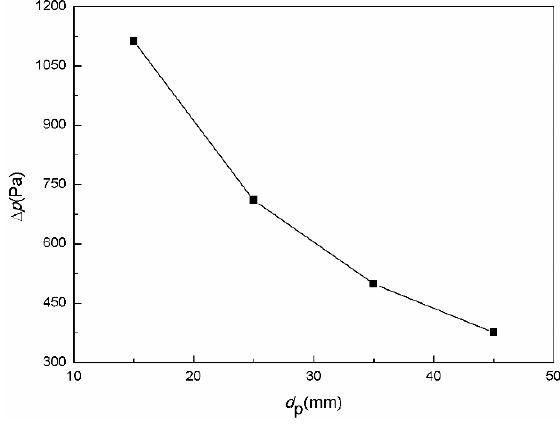
Figure 17. Influence of the sinter particle diameter on pressure drop.